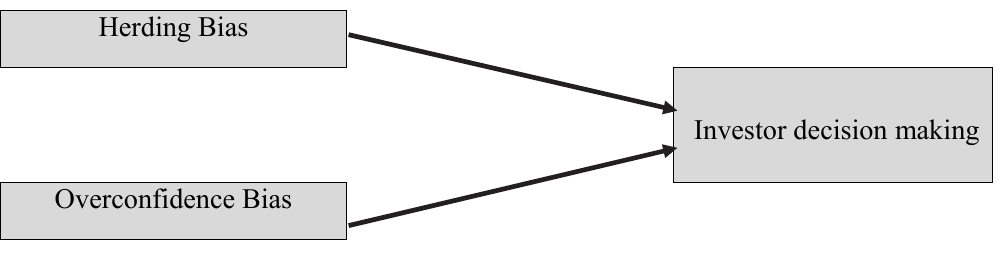
Fig. 1. The structure of the proposed